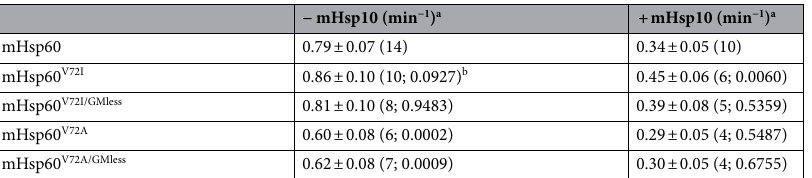
Table 2. ATPase activities of mHsp60 proteins in the absence and presence of mHsp10. a rates are expressed for per mHsp60 subunit, b errors are standard deviations calculated from multiple measurements; number of the measurement and p-value from the one-way analysis of variance for the V72 mutant vs. mHsp60 are indicated within the parentheses.